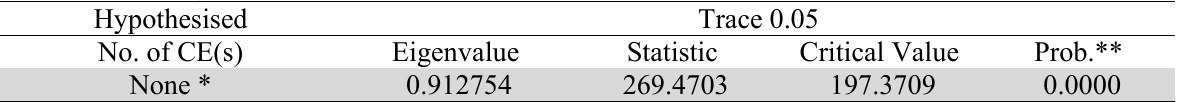
Result of Co-integration Johansen Test